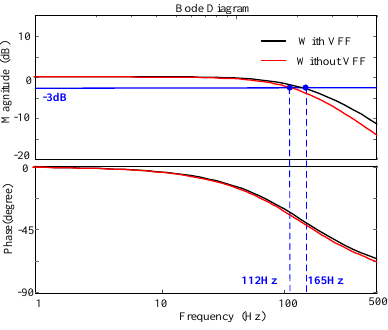
Figure 11. The bode diagrams of H fc (s).